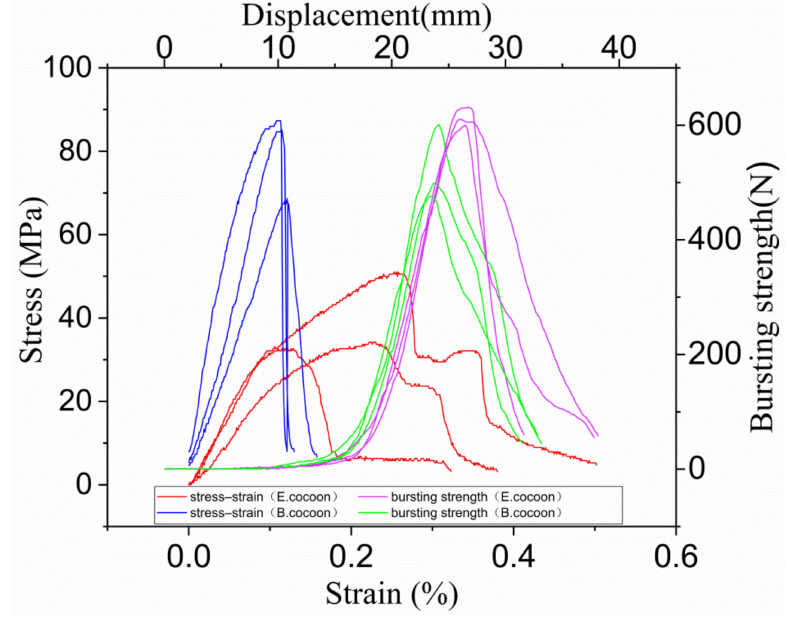
Figure 6. Stress–strain curves ( left ) and bursting strength curves ( right ) of the E and B cocoons. The average bursting strength and displacement of the E cocoon were about 570 ± 11 N and 27.7 ± 2 mm, respectively, which were about 1.3 and 1.2 times those of B cocoon (475 ± 51 N and 23.1 ± 2 mm), respectively, indicating its high energy absorption capacity. This is attributed to